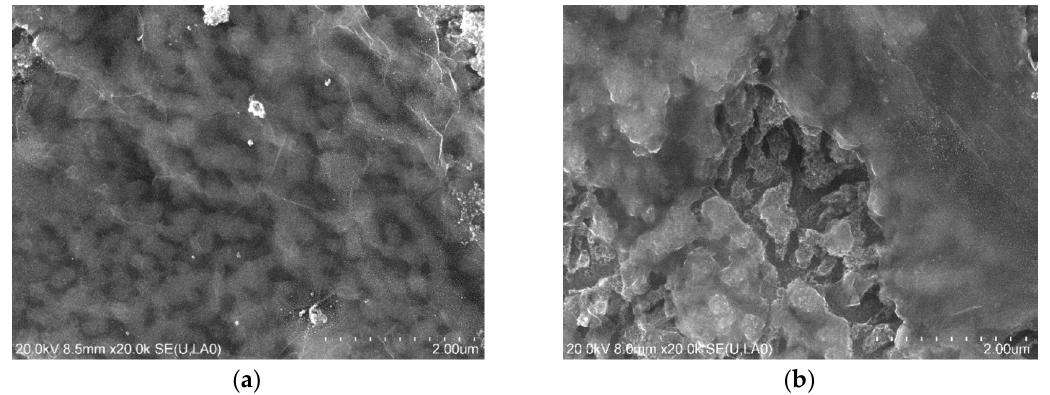
Figure 7. SEM image of TiO 2 -G film ( a ) after successive PEF reaction and ( b ) after storing in tap water for two days.